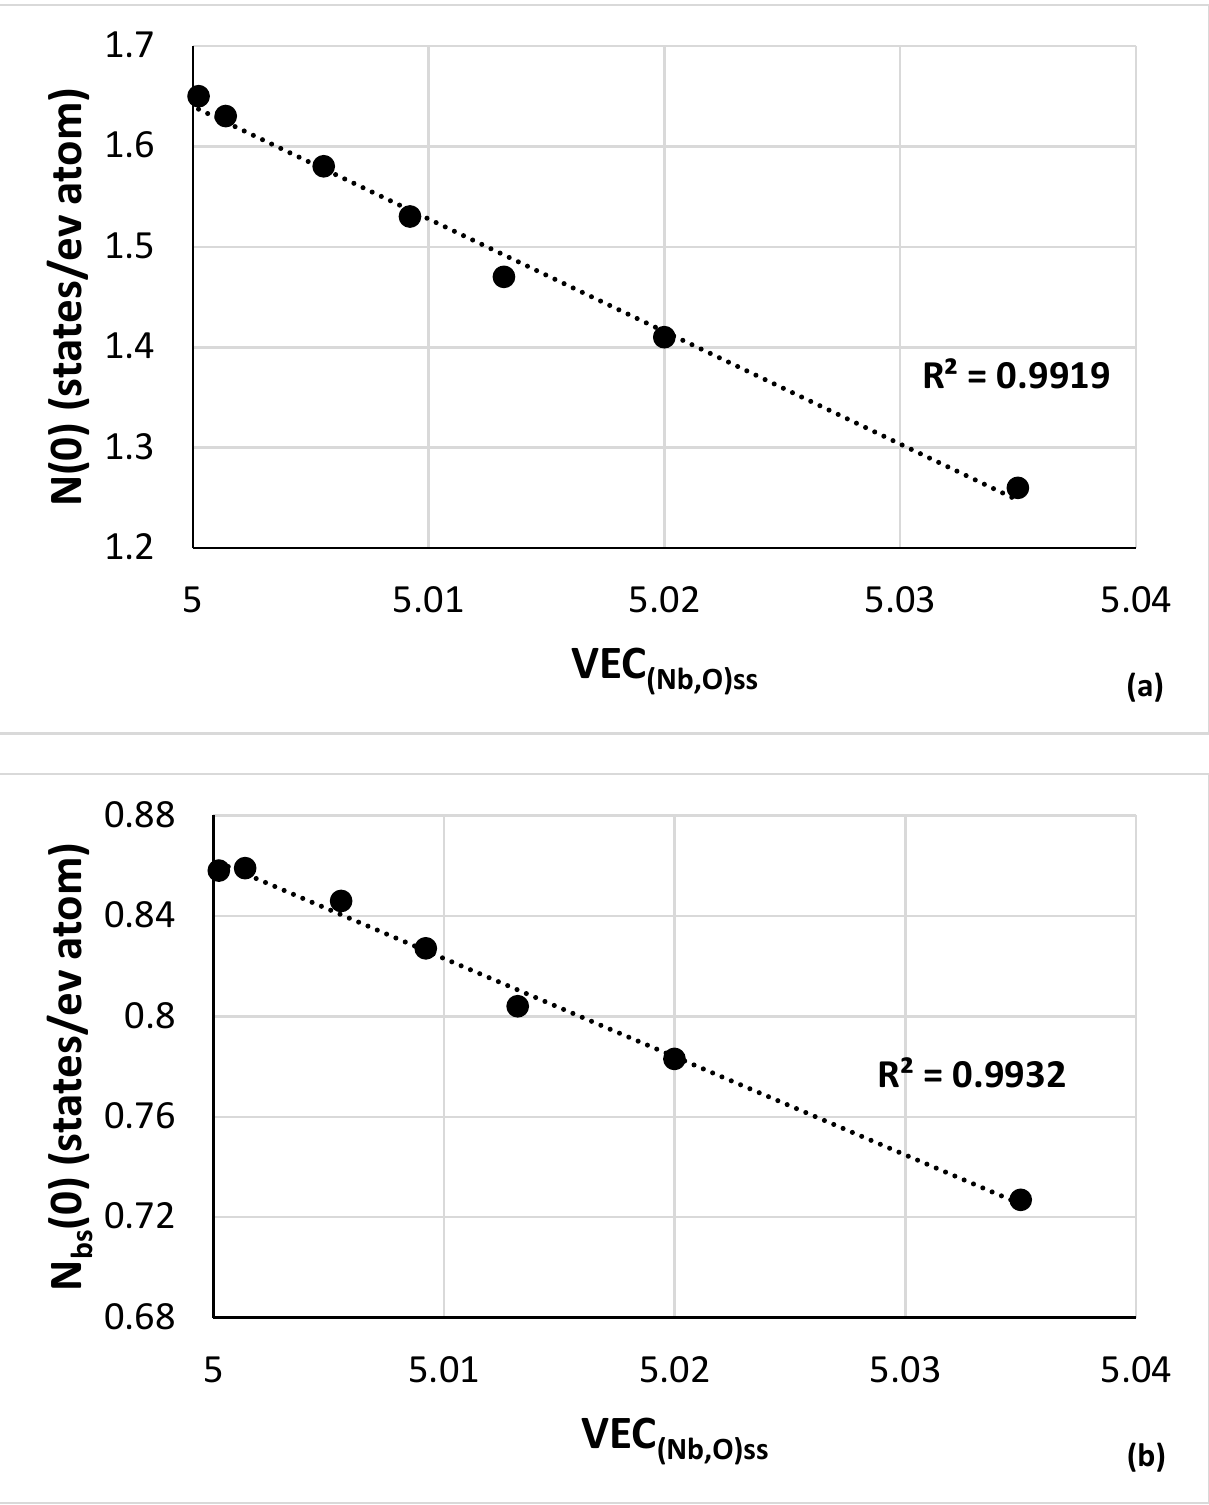
Figure 13. Data for Nb contaminated with oxygen. ( a ) density of electronic states at the Fermi level N(0) and ( b ) “band structure” density of states N bs (0) versus the parameter VEC of the (Nb,O) ss . For the Nb ss of the alloy NV1-HT, the hardness is HV ss NV1-HT = A ss NV1-HT [O] + Boron Free RM(Nb)ICs B ss NV1-HT . If we were to assume that B ss NV1-HT is the average of the measured micro- hardness values of the Nb ss in the bulk of NV1-HT given in [16] and in [82] and